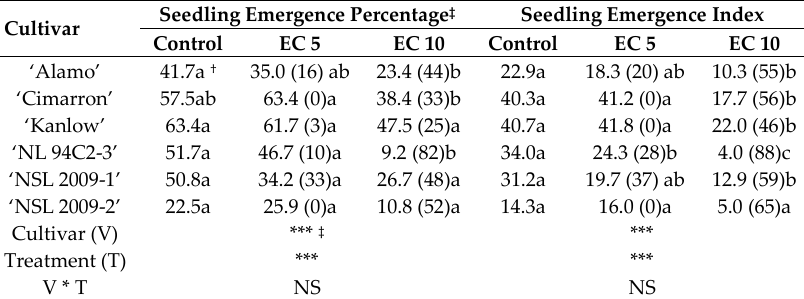
Table 3. Seedling emergence percentage and index of six switchgrass cultivars sub-irrigated with